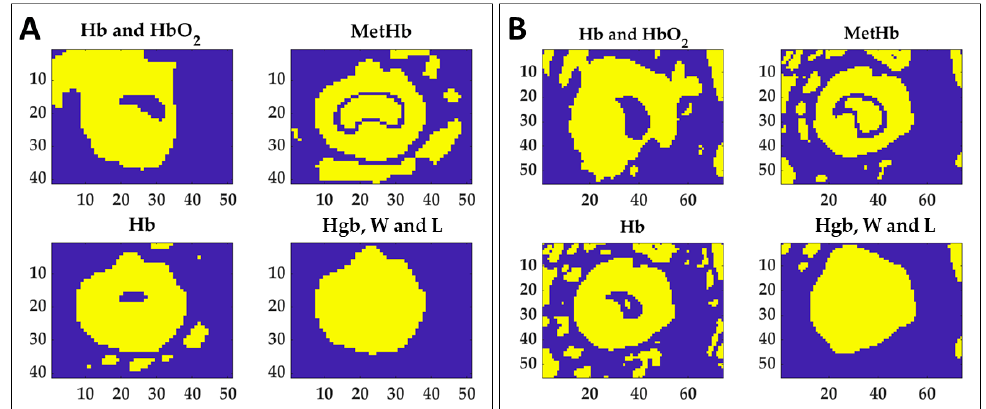
Figure 9. Percentage of normalized image variation ( ∆ NI t ( B ) during the ablation process.